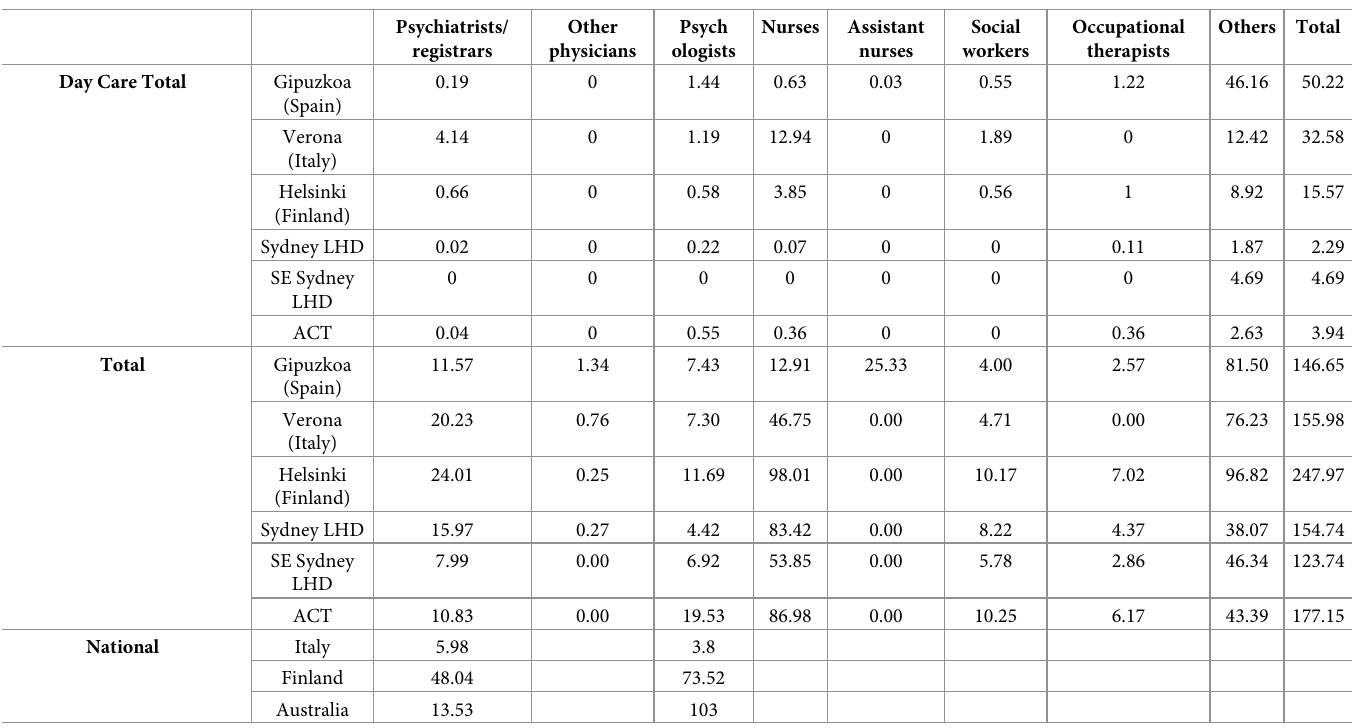
The total rate of psychologists per 100,000 adult population in all regions (ACT: 19.53, SES: 6.92,SLHD: 4.42, Gipuzkoa: 7.43, Verona: 7.3 and Helsinki: 11.69) (Table 1) was significantly different to their respective national averages (Australia:103; Italy:3.8; Norway:73.52). National data was not available for